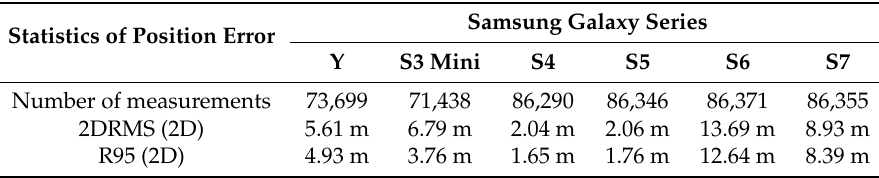
Table 2. Statistics for the Samsung Galaxy phones’ predicted position errors over the course of a 24-hour stationary measurement campaign